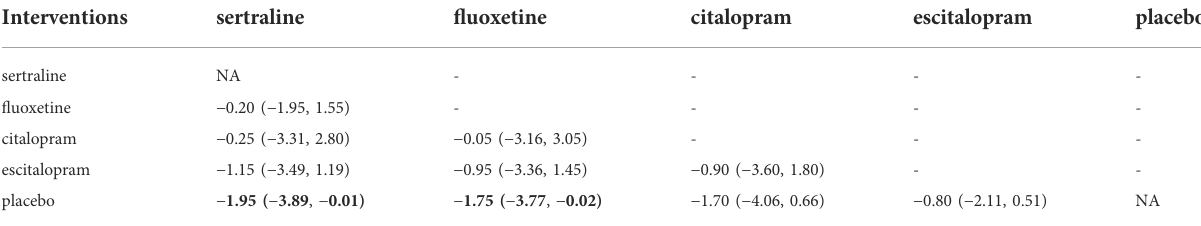
Figure 2C depicted the network plot for mean changes in the HAMD score. The results (shown in Supplementary Table